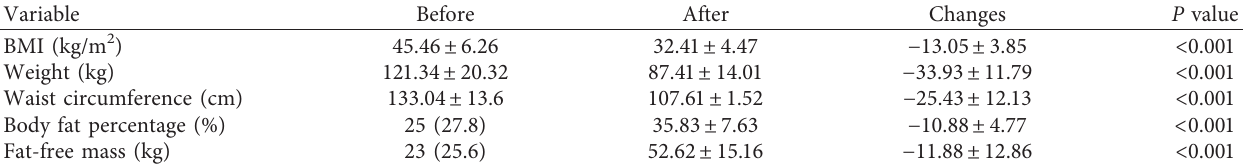
Table 2: Anthropometric indices in clinically severe obese patients before and after bariatric surgery. Variable Before After